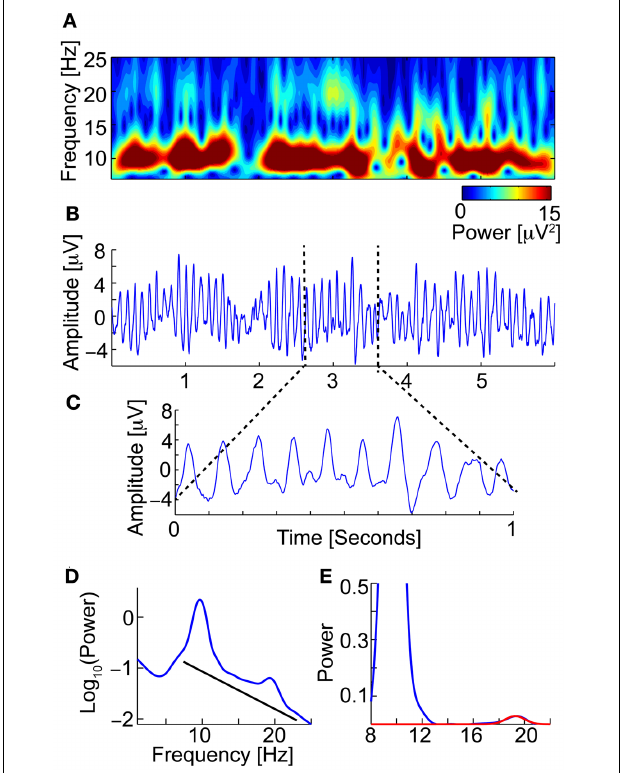
FIGURE 2 | An EEG biomarker is a quantitative measure derived from the EEG. For example the Beta peak frequency. (A) Time-frequency (TF-plot) plot of 6s of an eyes-closed rest EEG signal (from Pz) (Wavelet). The color shows the power. Low-amplitude bursts in the beta-frequency band (13–30Hz) not directly coupled with the strong alpha are observed. (B) The raw EEG signal used to calculate the TF-plot in (A) . Clear and strong alpha (8–13Hz) oscillations are observed. (C) Zooming in, we observe small peaks in the space between the strong alpha oscillation peaks, which correspond to the beta oscillations. (D) The power spectrum of the full-length EEG signal reveals a beta peak (left). To find the beta peak we first fit a 1/f baseline (right), next we fit a Gaussian to the small beta peak. We now have four biomarkers; Beta peak frequency, Beta peak width, Beta peak corrected power (i.e., minus 1/f baseline), and peak uncorrected